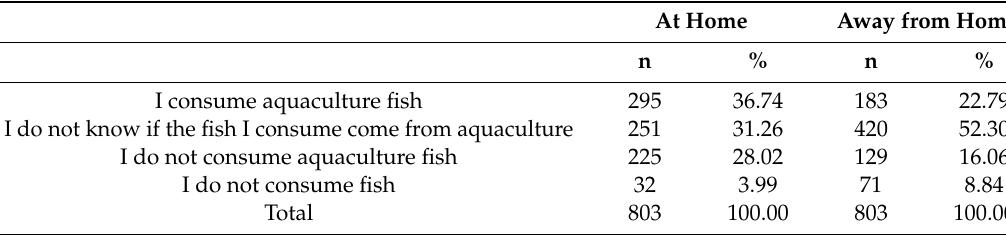
Table 2. Aquaculture fish consumed by the